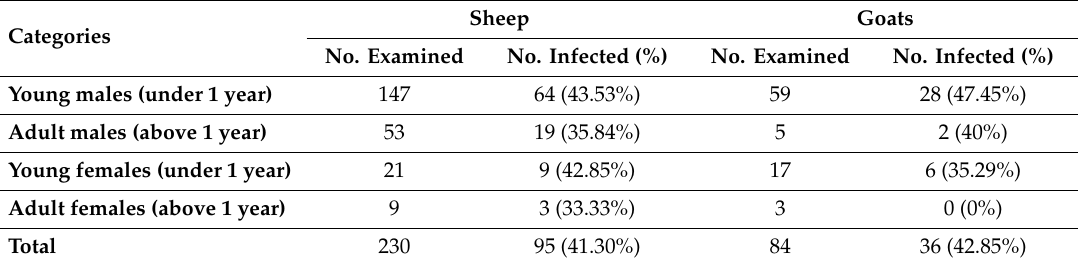
Table 3. Prevalence of Sarcocystis species among di ff erent categories of sheep and